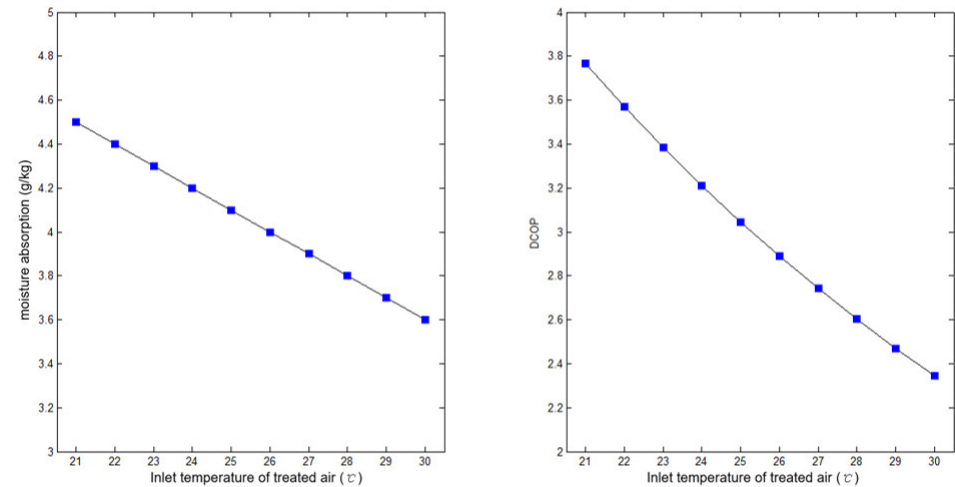
Figure 13. Effect of inlet air temperature on hygroscopicity D and DCOP.